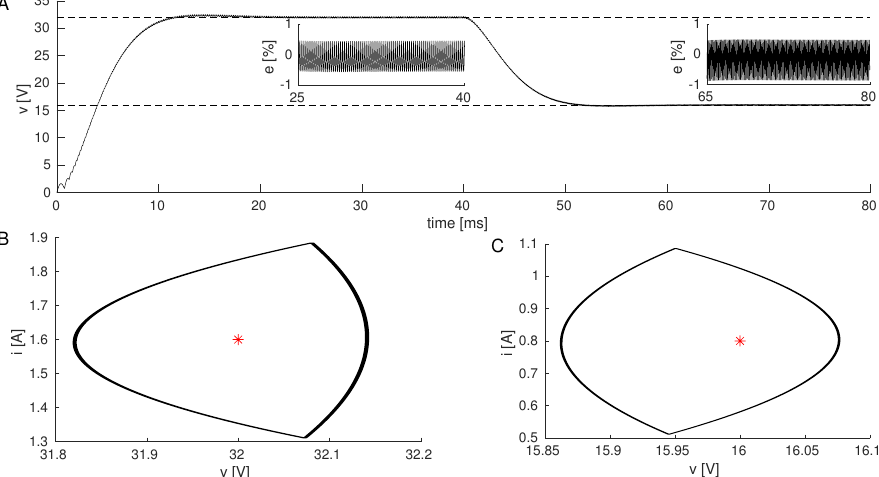
Figure 4. ( a ) Time trace of the voltage in the capacitor v . During the first 40 ms a ¯ v ref = 32 V is used, after this a drastic change to ¯ v ref = 16 V is applied (depicted in the dashed lines). The time trace of the steady state percentage error is also depicted in the insets for both values of ¯ v ref ; ( b ) Phase representation of the steady state for ¯ v ref = 32; ( c ) ¯ v ref = 16, with the equilibrium point indicated by the red star. This results were obtained by making c 1 / c 2 = 9 and δ = 1 × 10 − 4 . Steady state was considered after 25 ms of transient dynamics. Other parameters as in the main text and Figure